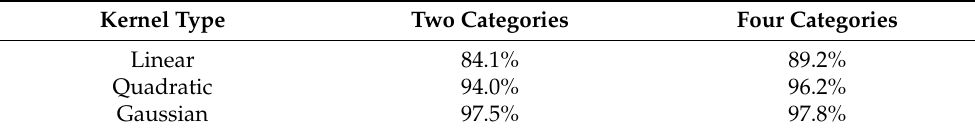
Table 5. Accuracy of each variable-frequency hammering in the two-category and four-category classifications. Kernel